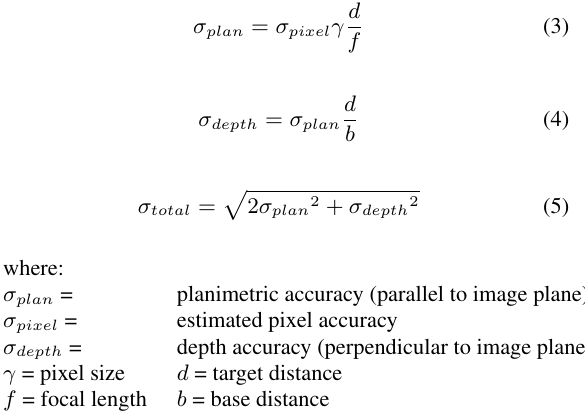
Figure 7: Predicted flight paths of polygons